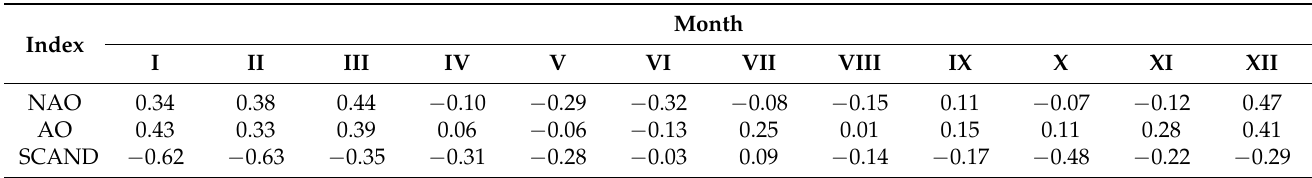
Table 5. The correlation coefficient between air temperature averaged by months over the Volga Federal District and some atmospheric circulation